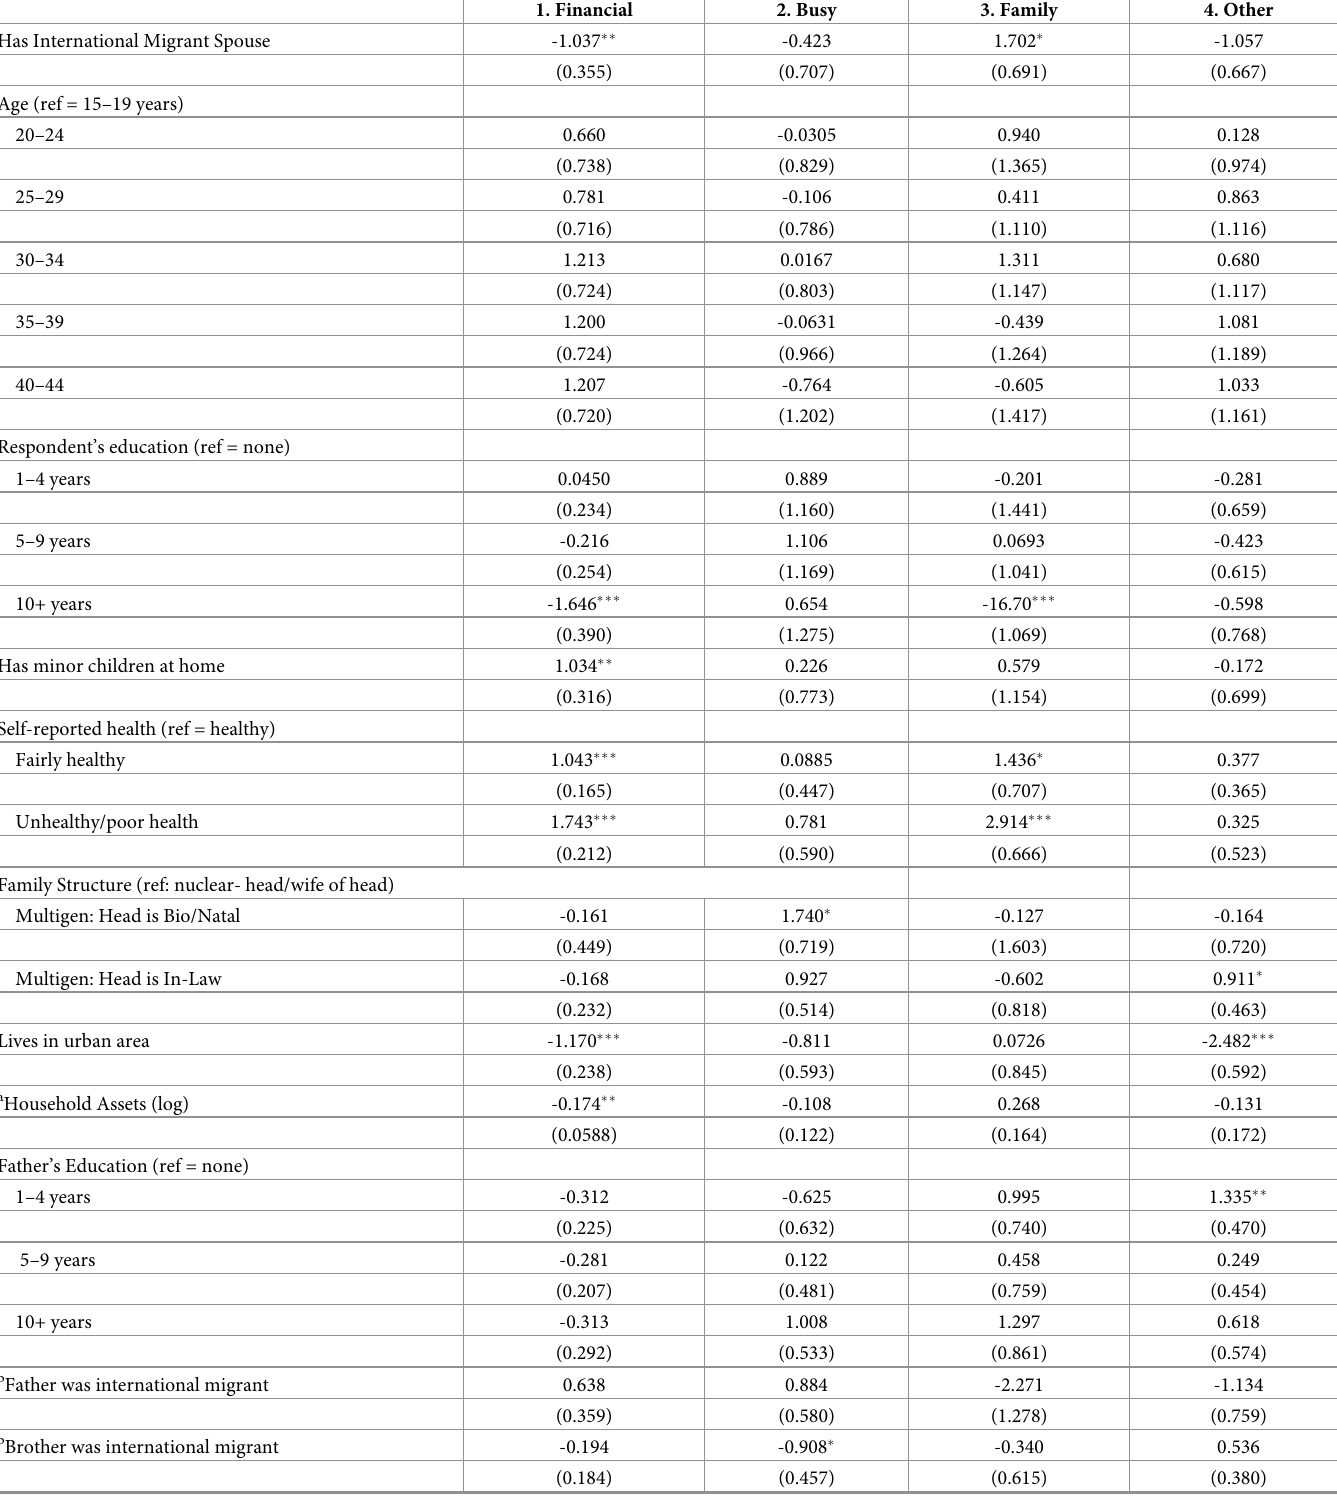
Table 4. Multinomial analysis of barriers to accessing needed